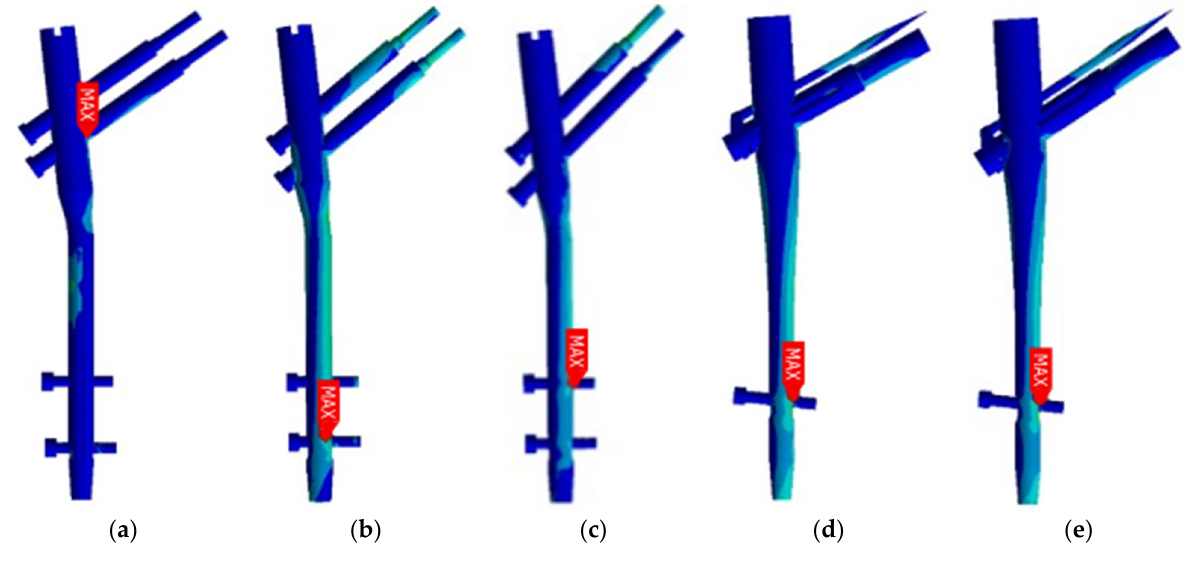
Figure 14. Stress distribution in the nail in the healed femur—( a – c ) Medin and ( d , e ) Tantum. The image corresponds with Figure 6.